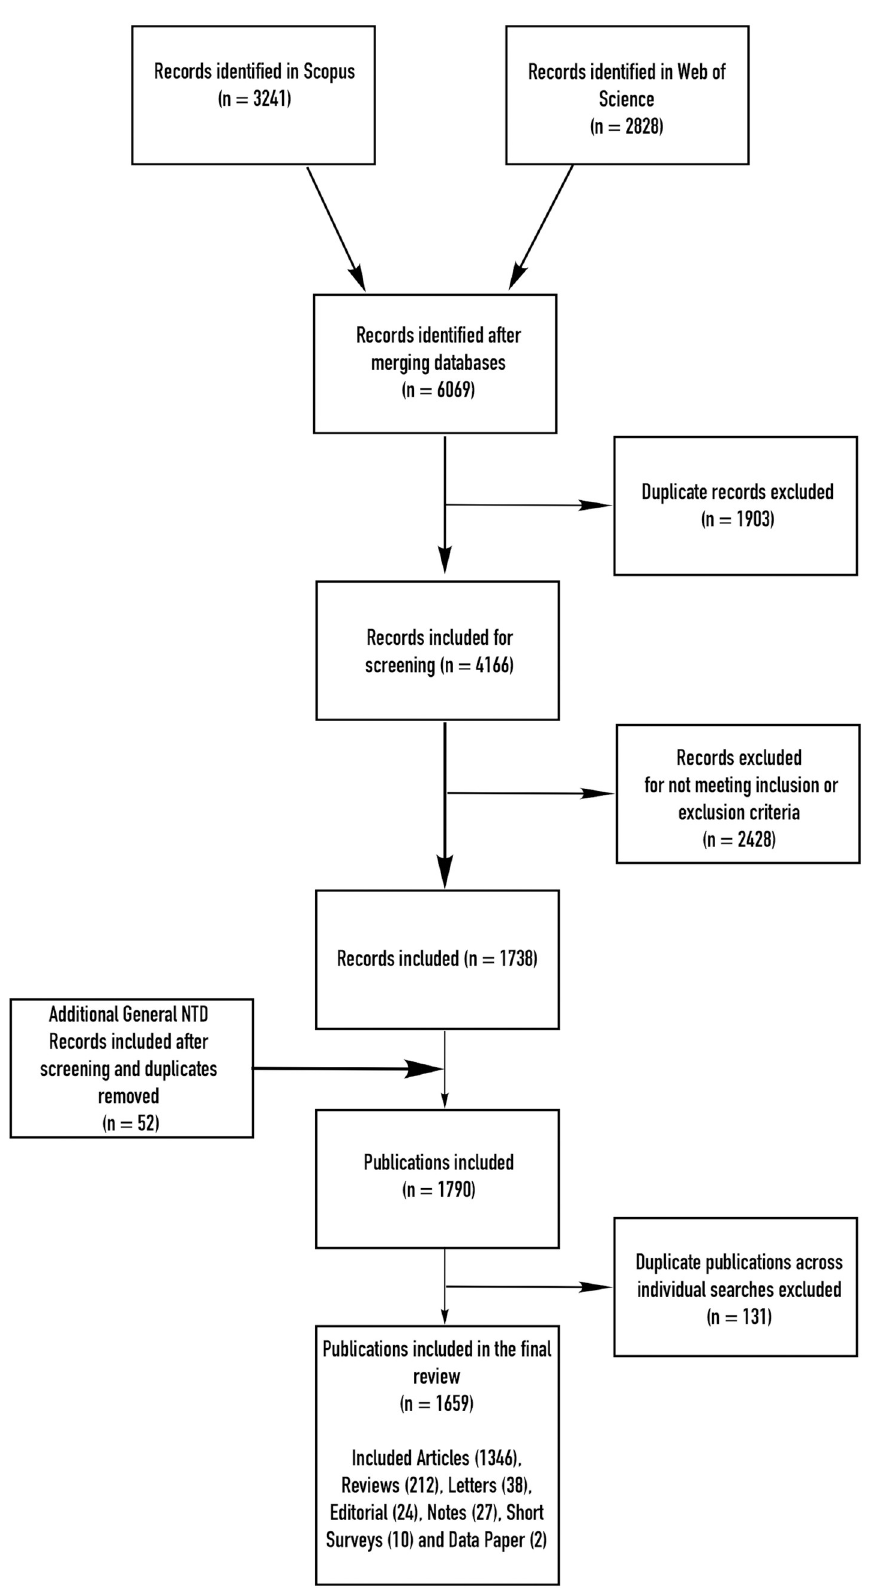
Fig 1. Combined results for 21 searches (the 20 NTDs independently, plus a search where NTDs were discussed in a general overarching way). NTD, neglected tropical disease.